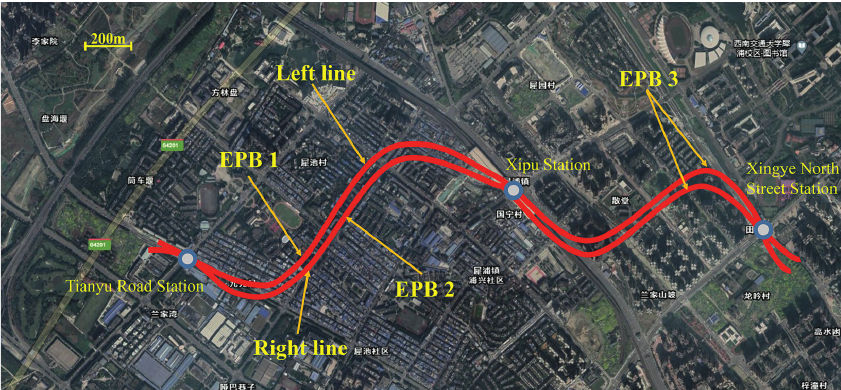
Figure 1: Layout and EPBs used in the two continuous intervals in Chengdu Metro Line 6. Table 1: Main working parameters of the three types of EPB shield machines.